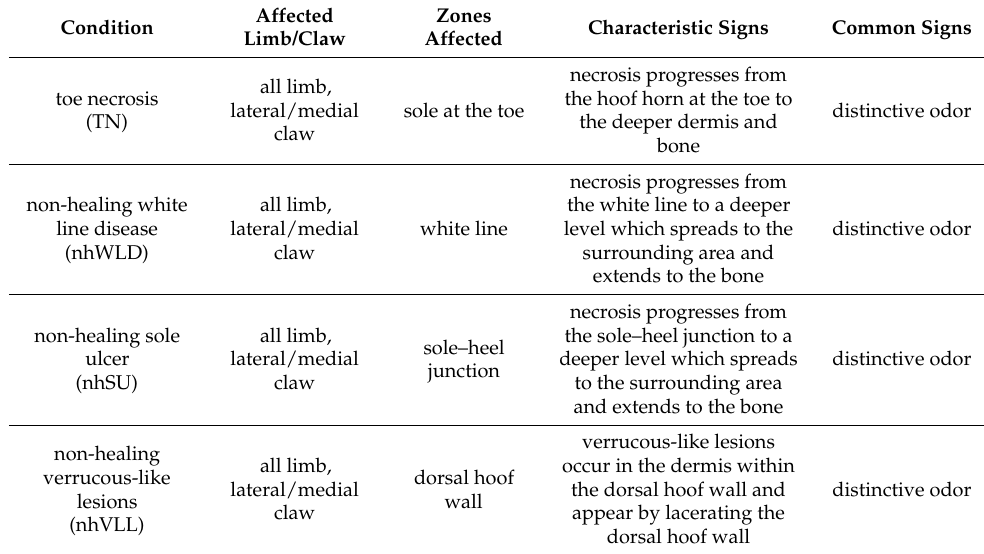
Table 1. A typical example of